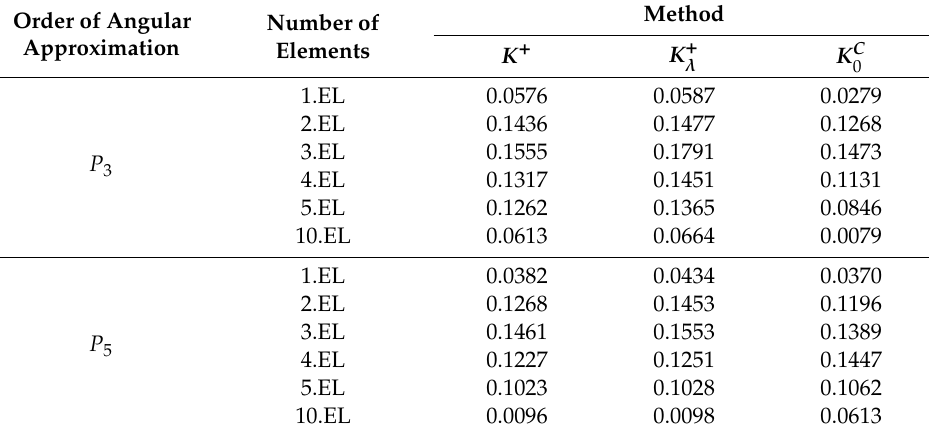
Table 6. Relative errors for P 3 , P 5 approximations with a set of elements for region 5. Order of Angular